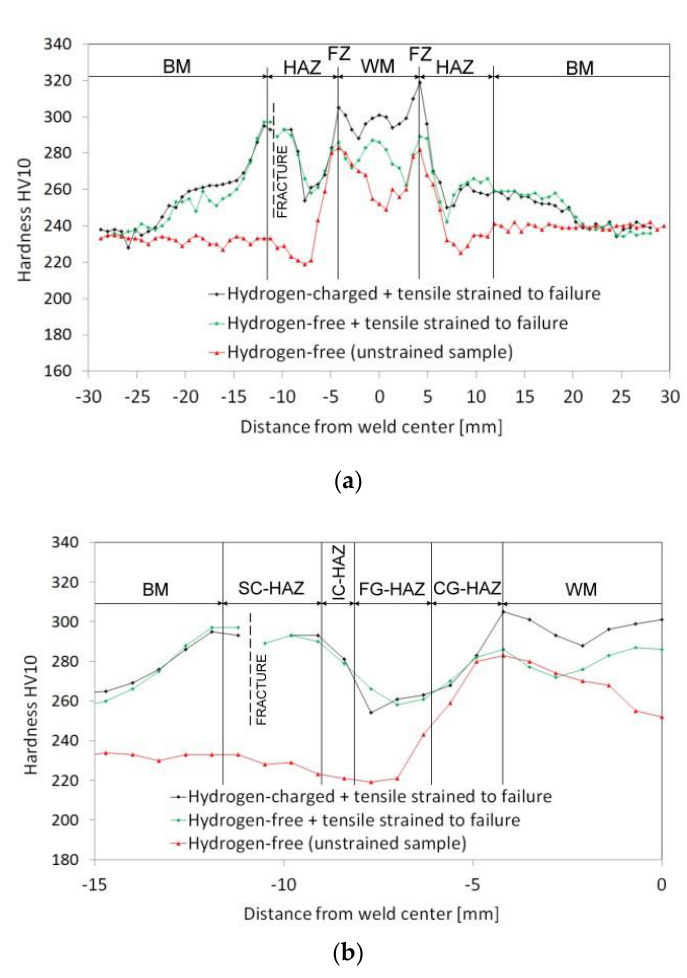
Figure 9. The effects of electrolytic hydrogenation and subsequent room-temperature tensile testing on cross-weld hardness profiles of T92/T92 weldments initially heat treated by conventional tempering PWHT-1: ( a ) overall hardness profiles and ( b ) detailed hardness profiles focused on the HAZ.